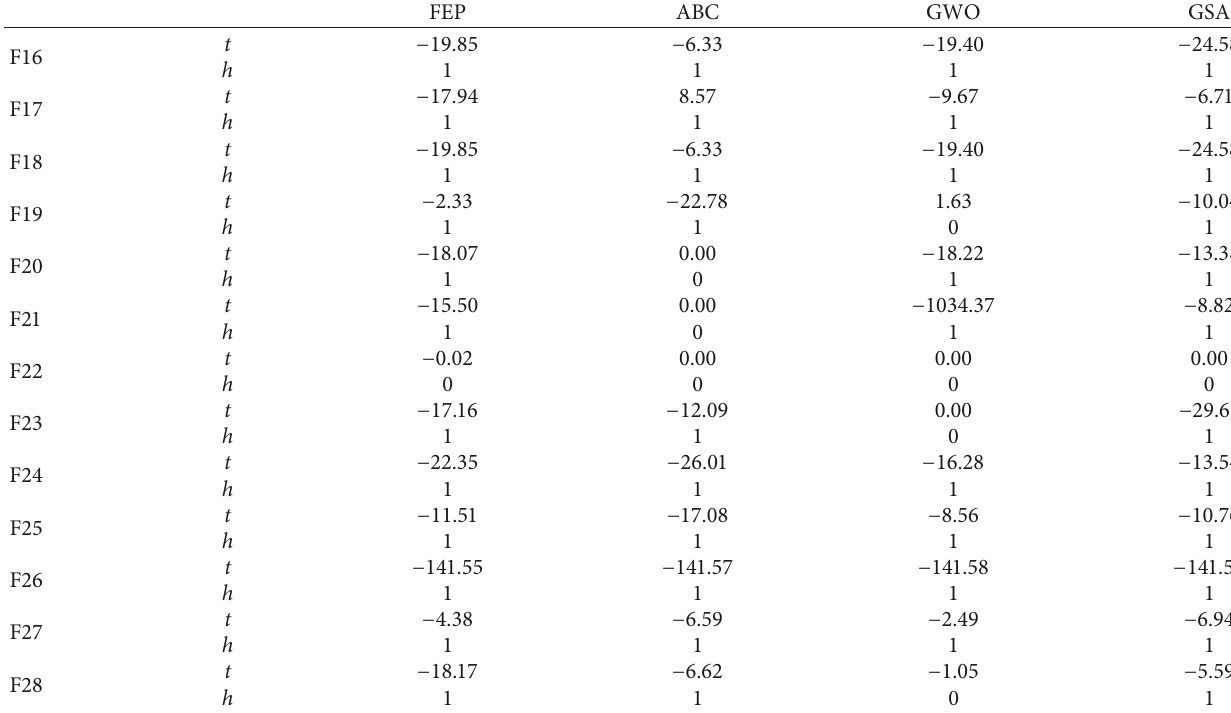
Table 12: t -test against FEP [15], ABC [29], GWO [7], and GSA